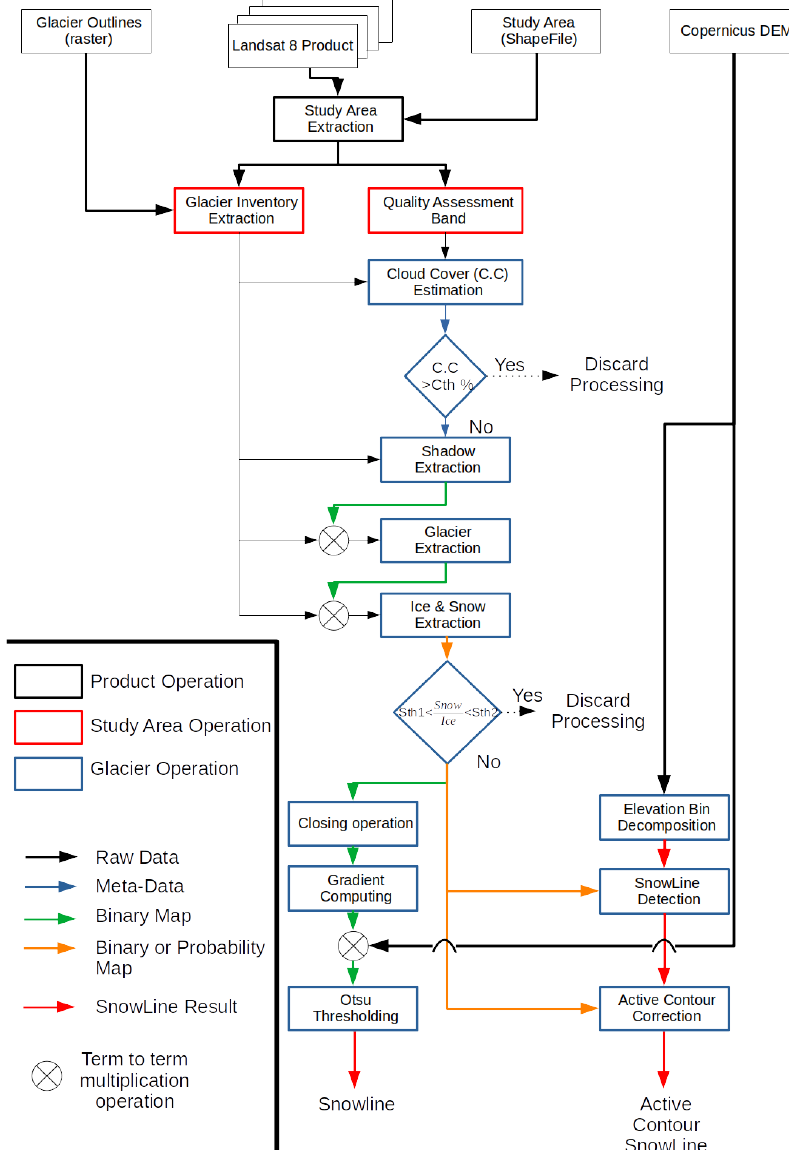
Figure 2. General flowchart of the proposed